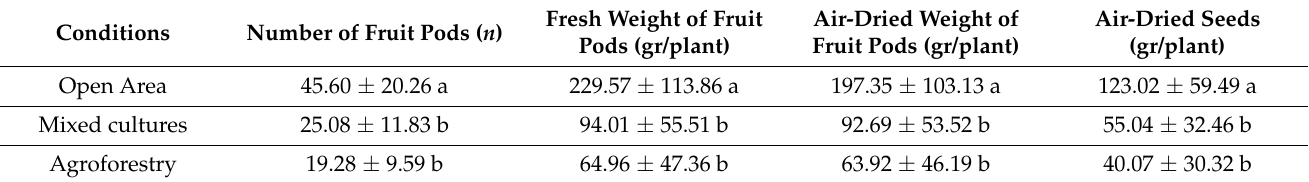
Table 2. Sacha Inchi first harvesting data.